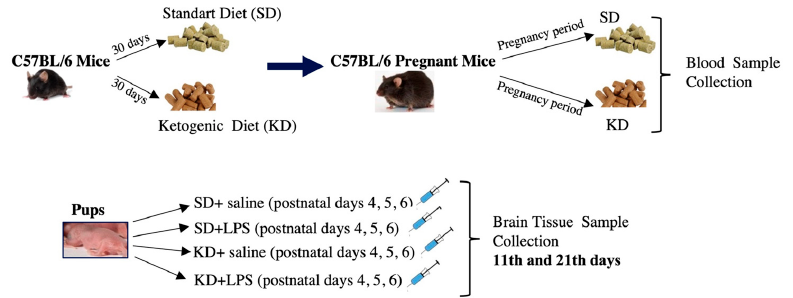
Figure 1. Schematic illustration of the experimental design of the